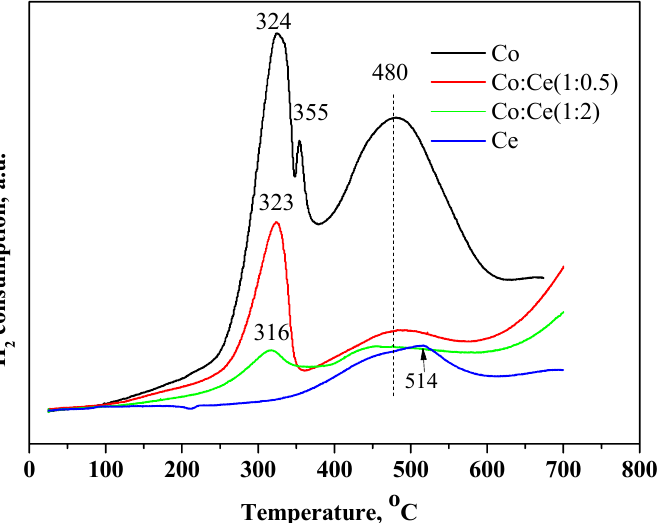
Figure 6. Temperature-programmed reduction (TPR) spectra of single- and bi-component cata- lysts.